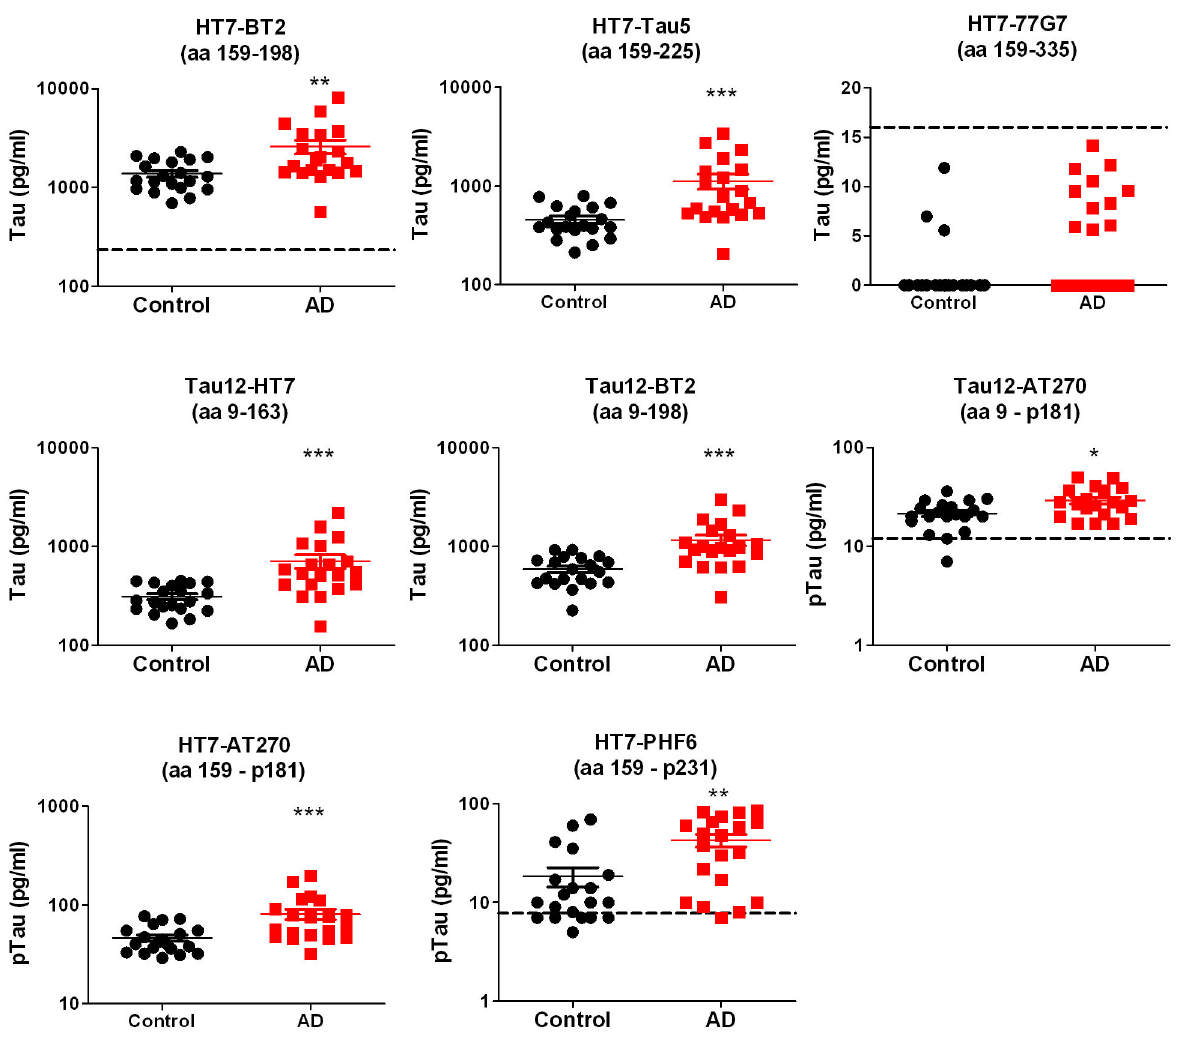
Figure 6. Tau and ptau levels in 20 AD and 20 control CSF samples. A set of 20 AD and 20 age-matched normal control CSF samples were analyzed using the tau ELISAs (HT7-BT2, HT7-Tau5, Tau12-BT2, Tau12-HT7 and HT7-77G7) and pTau ELISAs (HT7-AT270, HT7-PHF6 and Tau12-AT270). Dashed lines indicate the assay LLQ corrected for CSF dilution. Statistics based on 2- tailed Student’s t test comparison of log-transformed data, * p < 0.05; ** p< 0.01; *** p < 0.001. doi: